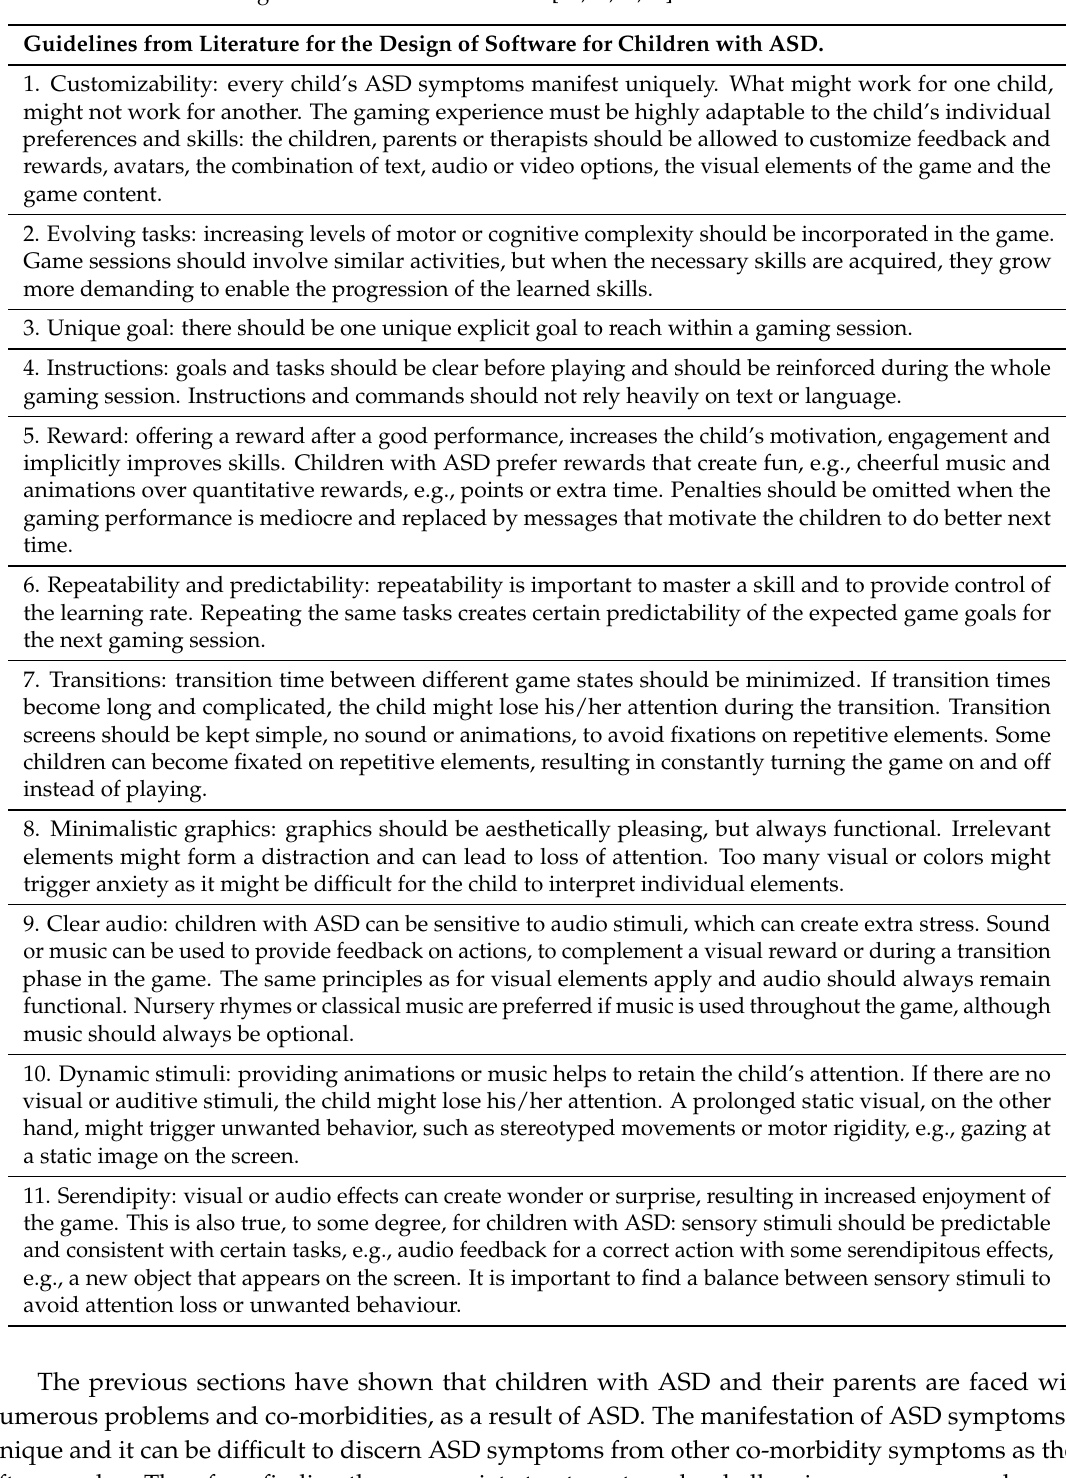
Table 4. An overview of the guidelines found in the literature regarding the design and implementation of software or serious games for children with ASD